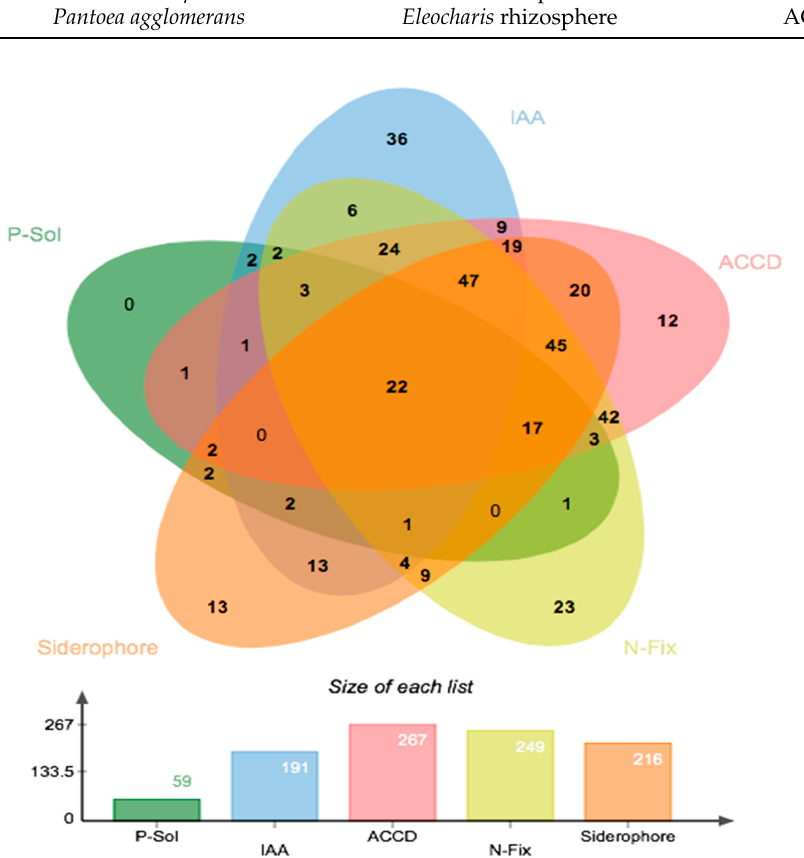
Figure 6. Bacterial isolates with plant growth-promoting (PGP) properties. (Above) Venn diagram showing the number of isolates that possess one or many of the five PGP traits. (Below) Bar graph indicating the absolute numbers of bacterial isolates having each of the PGP traits under investigation (over 438 isolates tested).